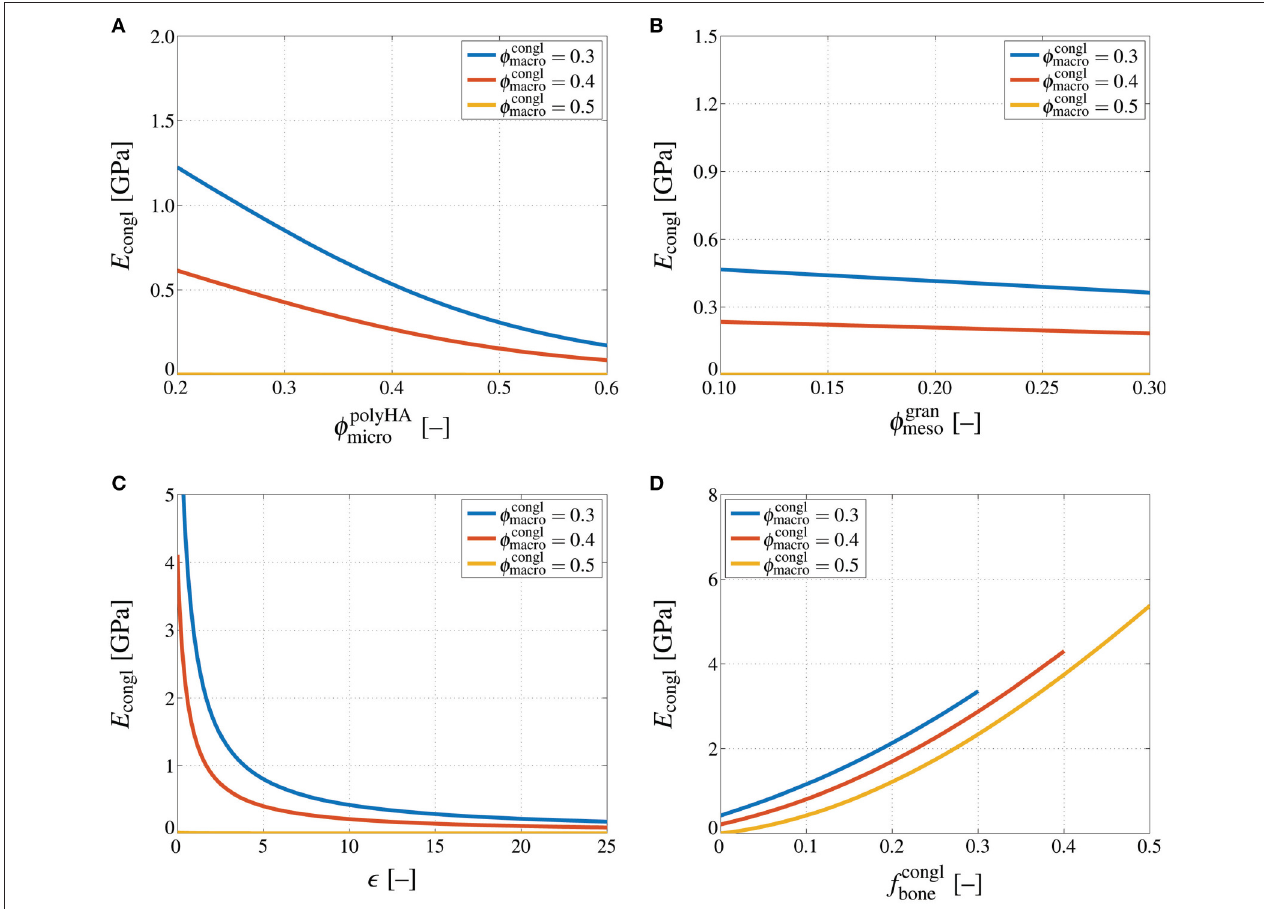
FIGURE 5 | Influences of porosities, crack density, and bone tissue volume fraction on the conglomerate stiffness. Young’s modulus of the macroscopic scaffold material, E congl , in GPa, computed for varying macroporosity, φ congl macro [0.1 , 0.3], (C) varying crack density, ǫ mesoporosity, φ gran meso =